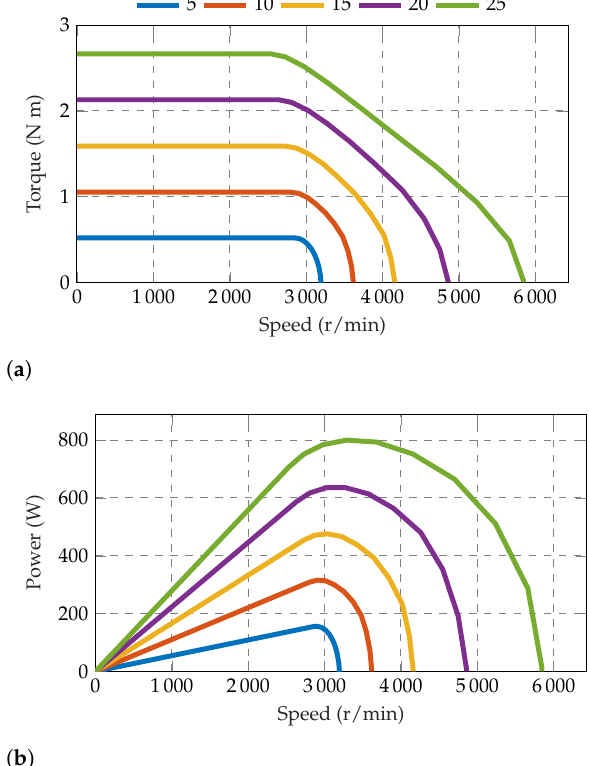
Figure 26. Torque and power versus speed. ( a ) Torque versus speed. ( b ) Power versus speed.